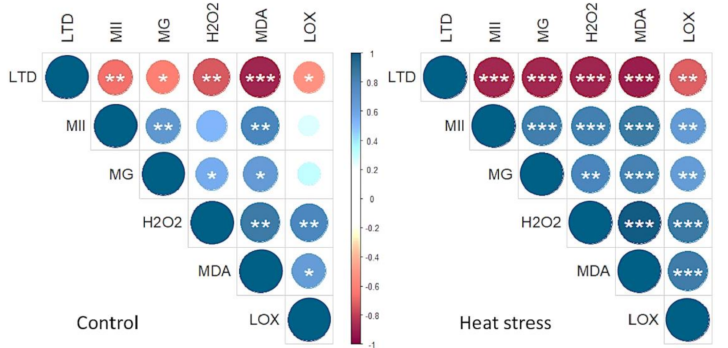
Figure 10. Correlation coefficients among the parameters that collectively induced oxidative stress. The parameters included LTD (leaf Table 2. O 2 (hydrogen peroxide) and LOX (lipoxygenase). ***, ** and * indicate significant at p ≤ 0.001, p ≤ 0.01 and p ≤ 0.05,